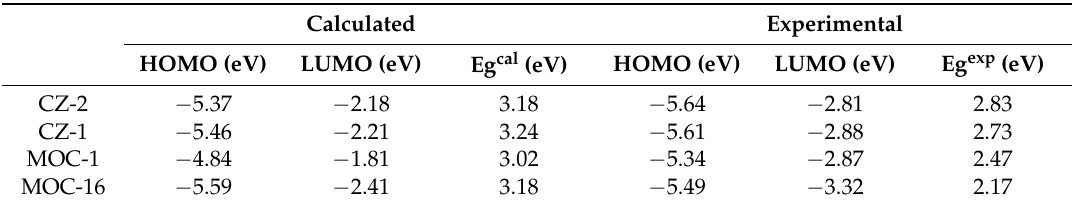
Table 1. Theoretical and experimental HOMO-LUMO energy levels (eV) of CZ-2, CZ-1, MOC-1 and MOC-16 using DFT at the B3LYP/6-31G* level and cyclic voltammetry. Calculated Experimental HOMO (eV) LUMO